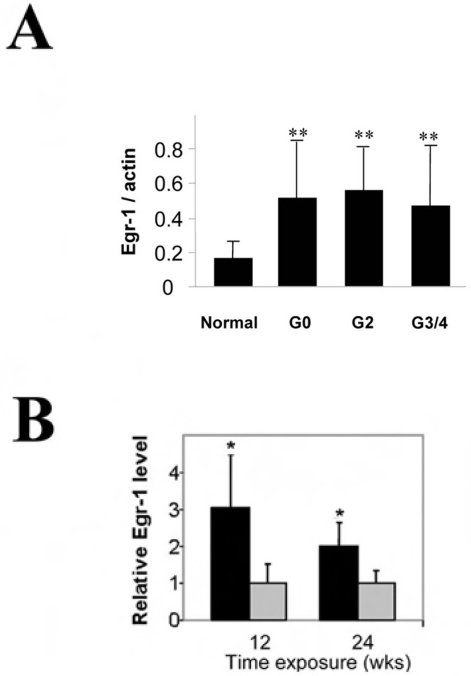
Expression of Egr-1 in vitro and in vivo in response to cigarette smoke.(A) Lung tissue samples from various stages of COPD (GOLD0 to GOLD3/4) were analyzed for expression of Egr-1 in lung tissue by Western immunoblot analysis, and normalized to β-actin expression. (B) C57BL/6 were exposed to chronic cigarette smoke exposure (black bars) or air (grey bars) for 12 or 24 weeks and Egr-1 expression in the lung was determined by Western immunoblot analysis. β-Actin served as the standard. (n = 12). *indicates P<0.05, **indicates P<0.01. N.S., not significant.